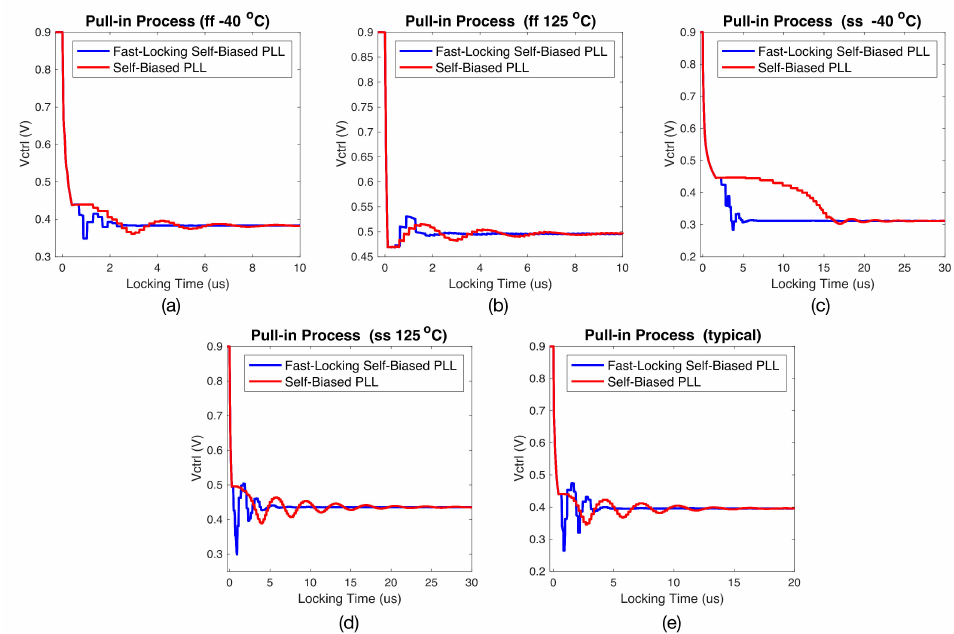
Figure 10. ( a ) Pull-in process of the self-biased PLL with and without fast-locking module in ff corner and − 40 ◦ C, ( b ) Pull-in process of the self-biased PLL with and without fast-locking module in ff corner and 125 ◦ C, ( c ) Pull-in process of the self-biased PLL with and without fast-locking module in ss corner and − 40 ◦ C, ( d ) Pull-in process of the self-biased PLL with and without fast-locking module in ss corner and 125 ◦ C, and ( e ) Pull-in process of the self-biased PLL with and without fast-locking module in typical condition (f vco = 2 GHz, N =